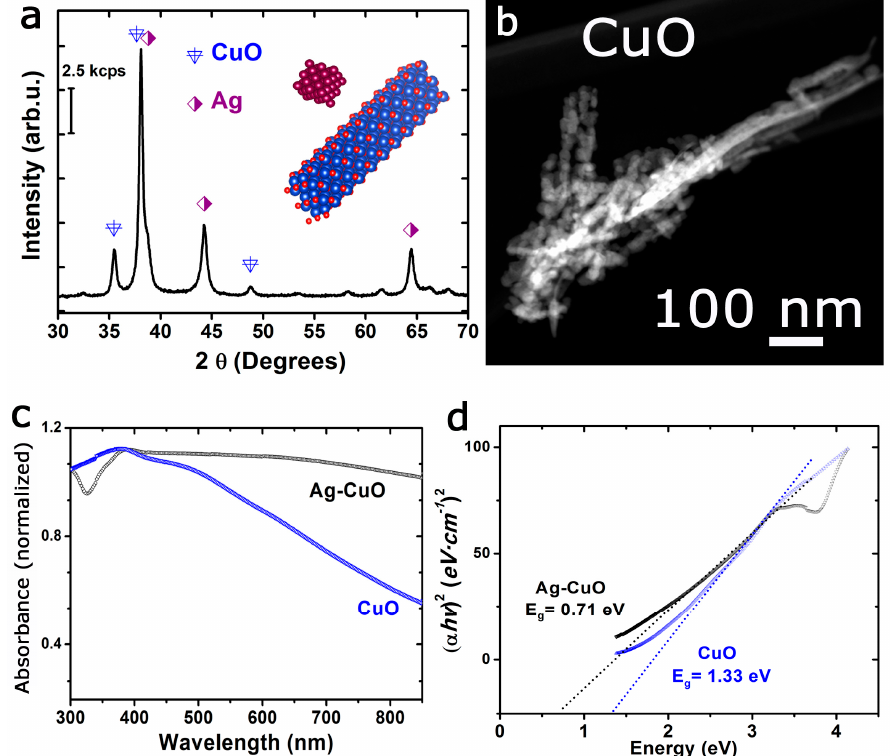
Figure 2. Additional characterization of the photocatalytic materials: ( a ) X-ray diffractogram of the Ag-CuO hybrid material accounting for the presence of both cubic and monoclinic crystallographic phases for silver and copper oxide, respectively; ( b ) HAADF-STEM representative image of the silver-free CuO nanostructures; ( c ) UV-Vis-Near Infrared absorption spectra of the Ag-CuO and CuO nanomaterials; ( d ) Tauc plots for the determination of the band gap energies for Ag-CuO and CuO structures assuming an indirect transition.